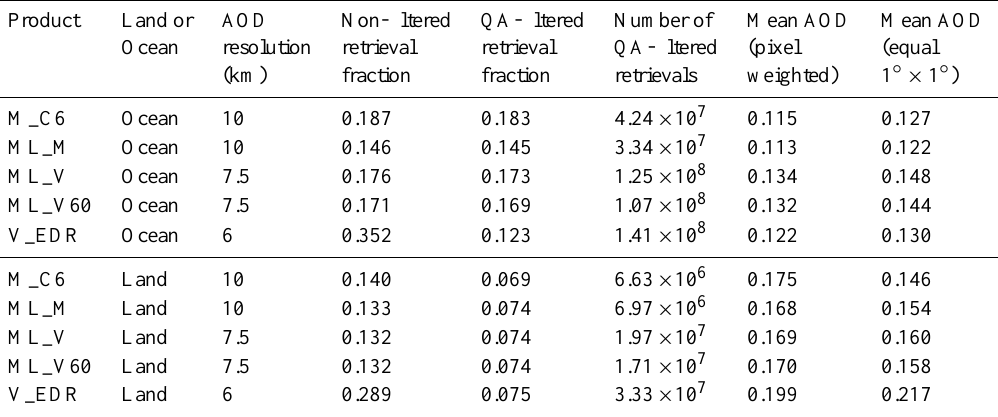
Table 5. Spring 2013 (March–April–May) statistics of QA-filtered AOD, retrieved over ocean (top) and land (bottom). QA-filtering for the MODIS and MODIS-like products is QAC ≥ 1 over ocean and QAC = 3 over land, whereas for the VIIRS EDR it is QAC = 3 only for both